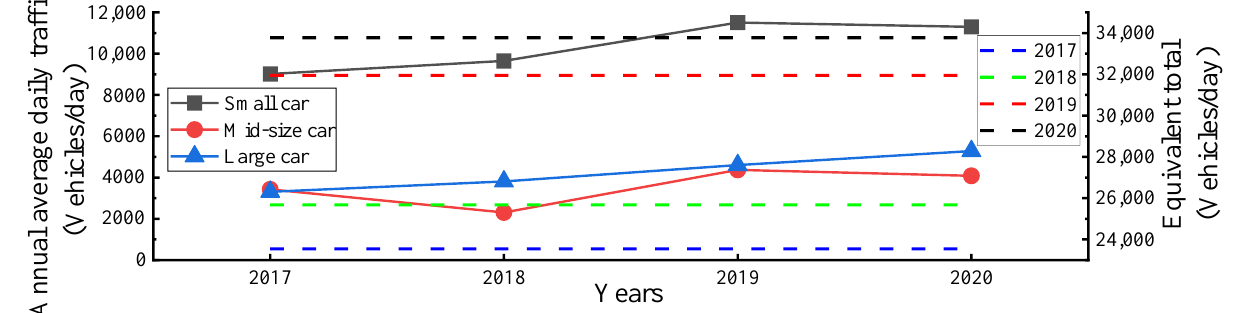
Figure 3. Traffic flow diagram of the Haoshanyu Tunnel.